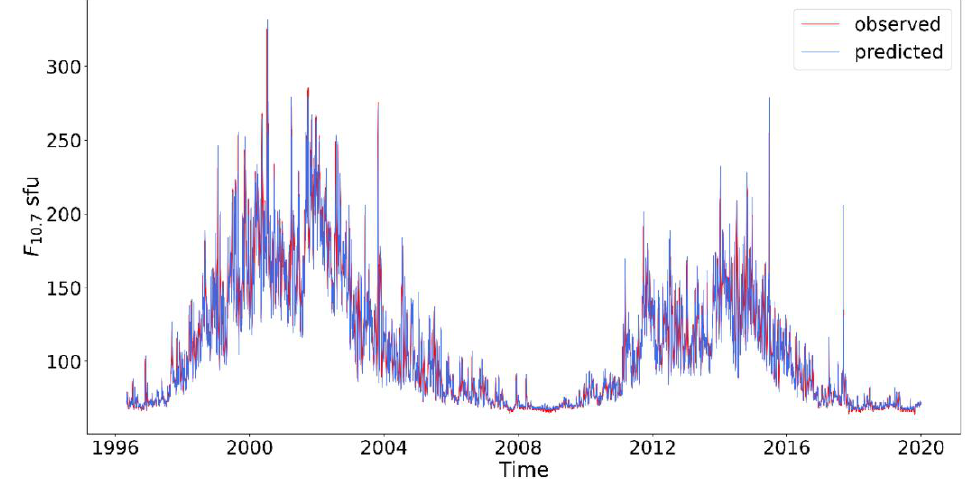
Figure 4. Three-steps-ahead (3-day forecast) prediction of the LSTM model with the observed (red line) and predicted (blue line) F 10.7 from 1996 to 2019.